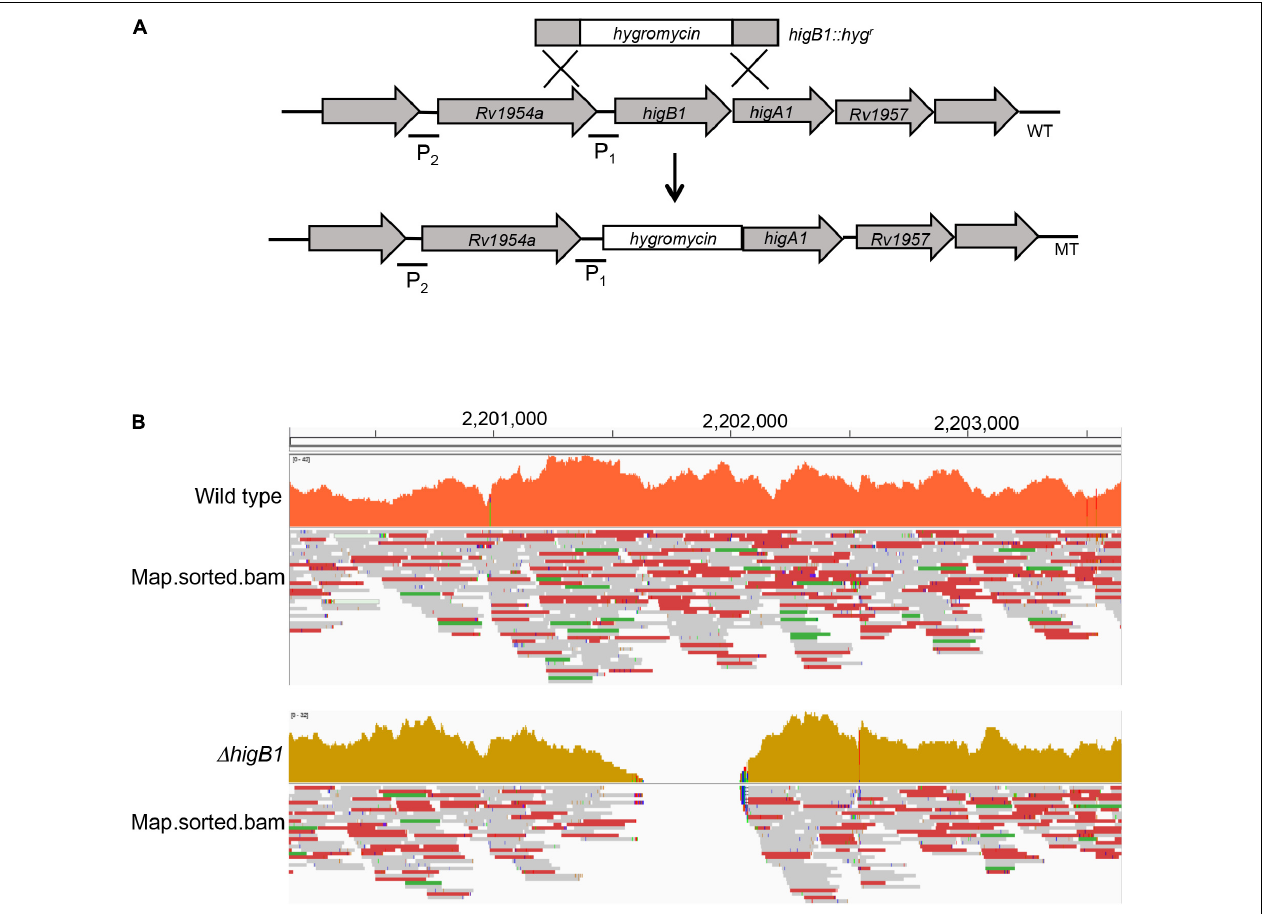
FIGURE 1 | Illustrative representation of higBA 1 operon in the wild type and mutant strain of M. tuberculosis. (A) The open reading frame of the higB 1 gene in the genome of M. tuberculosis was replaced with the hygromycin resistance gene using temperature sensitive mycobacteriophages. P1 and P2 stands for promoter region 1 and promoter region 2, respectively. (B) The replacement of higB 1 open reading frame by hygromycin cassette in the (cid:49) higB 1 mutant strain was confirmed by the whole genome